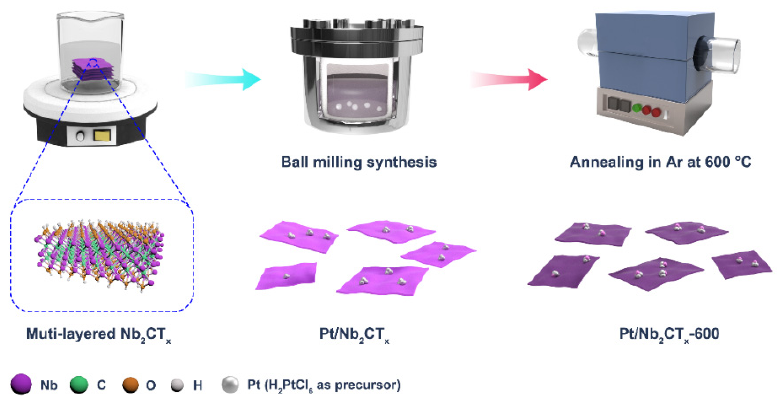
Figure 1. Schematic illustration of the preparation ofNb 2 CT x -600 catalyst by ball milling and ther- mal treatment.